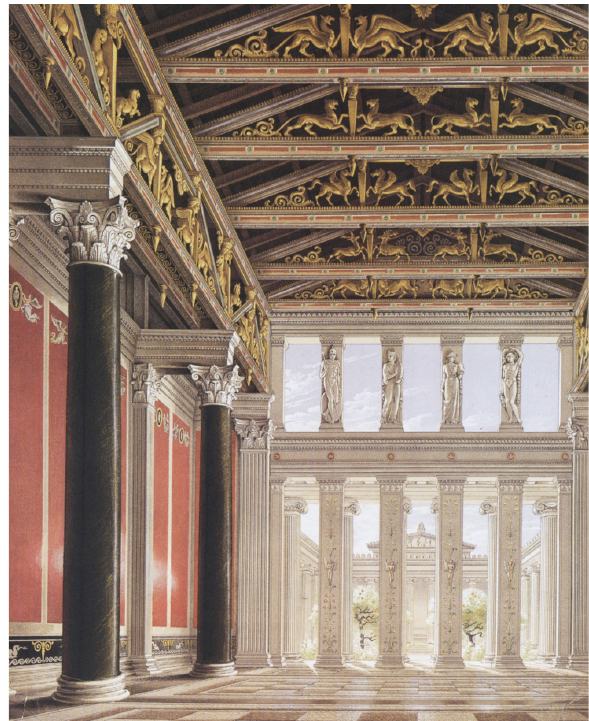
Figure 3 – Schinkel, K.F. Royal Palace in the Acropolis. Inside the vast reception room